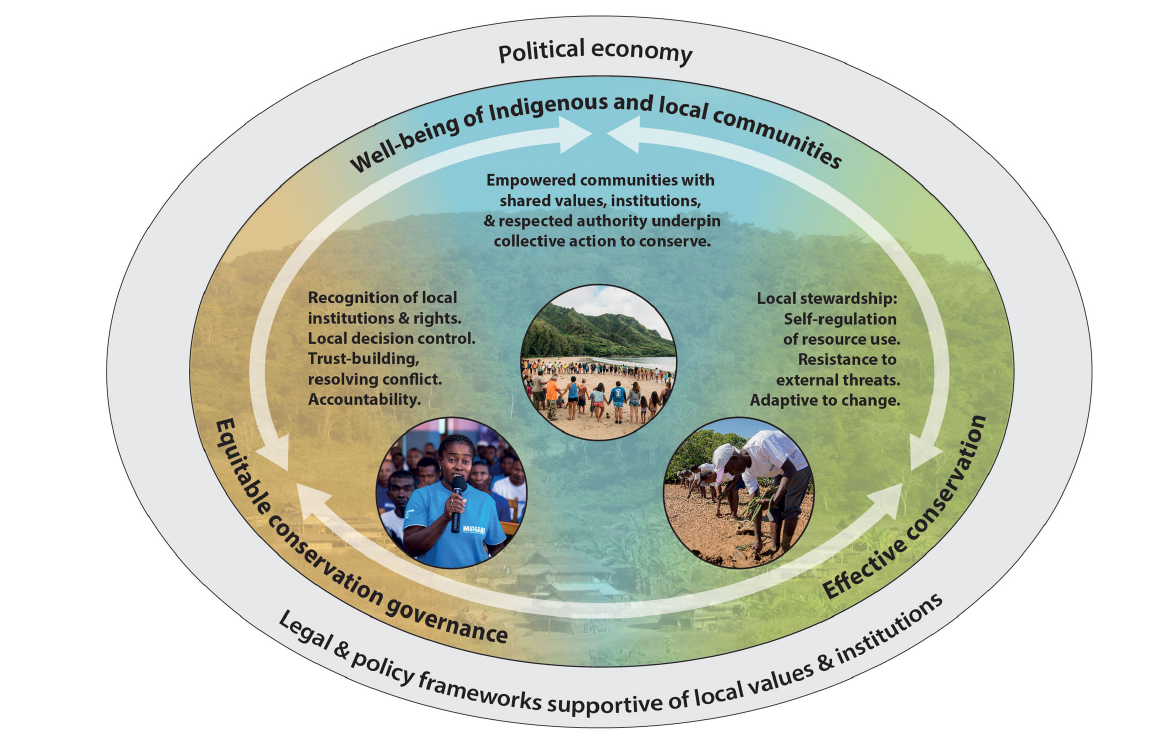
Fig. 5 . The central and inseparable role of Indigenous peoples and local communities in equitable and effective biodiversity